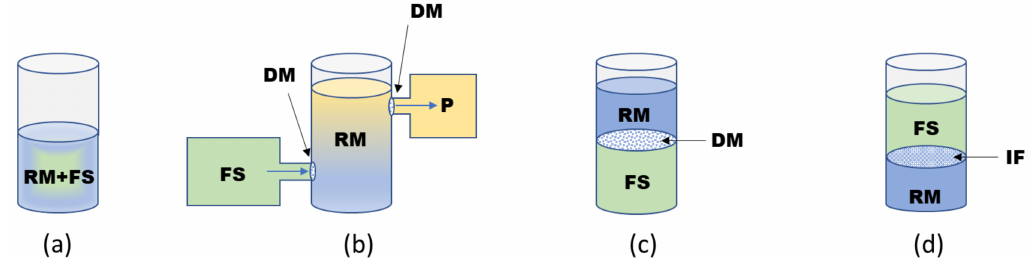
Figure 3. Schematic representation of the di ff erent formats of CF synthesis methodology. ( a ) The batch format utilizes one vesicle comprising both reaction medium (RM) and feeding solution (FS). ( b ) Continuous-flow CF methodology: FS is permanently pumped in RM through the dialysis membrane (DM); the newly synthesized proteins or by-products are removed from the RM by passing through the DM with other cut-o ff pores, allowing for target protein collection. ( c ) Continuous-exchange CF is based on dialysis through the membrane, allowing for the constant substrate addition and by-product removal from the RM. ( d ) Bilayer format: RM and FD represent two di ff erent liquid phases; the exchange and prolonged protein synthesis occur at the phase border or interphase